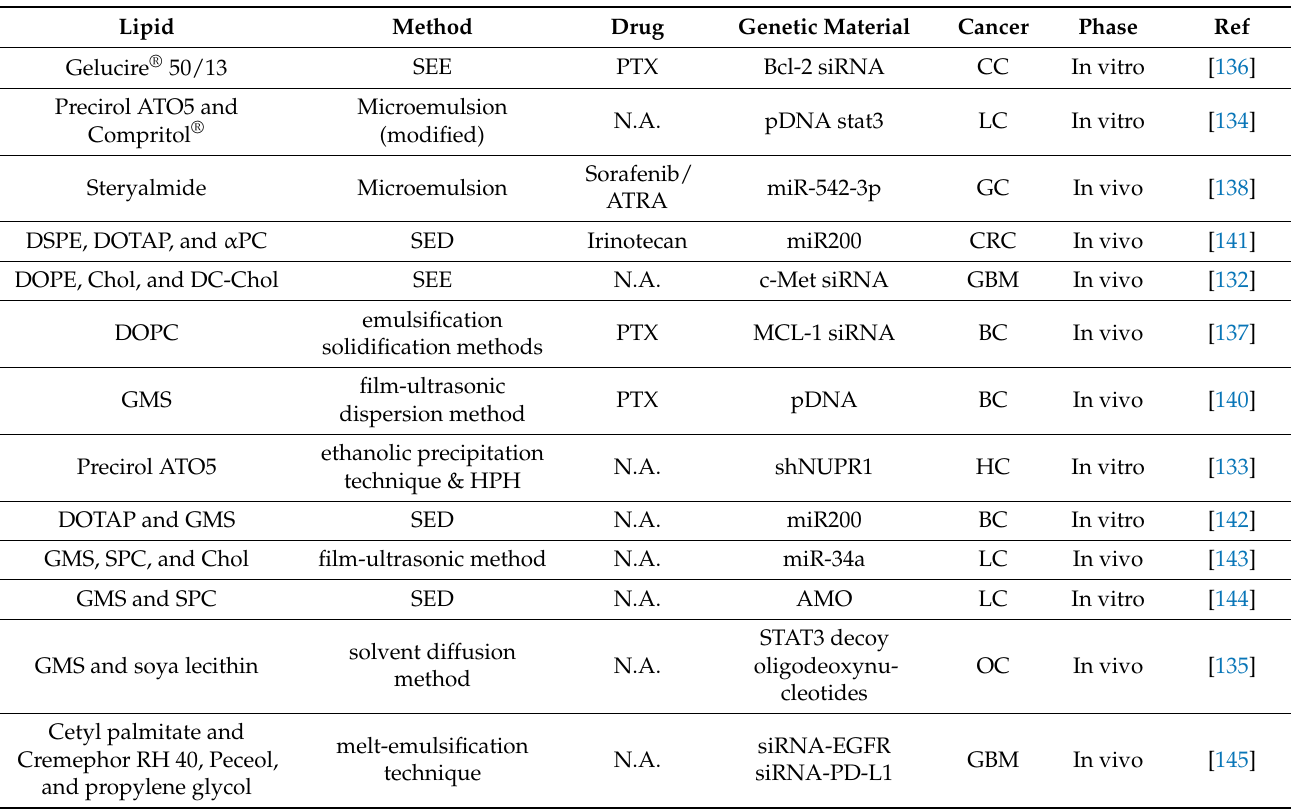
Table 5. SLNs with different genetic material for different cancer types in different stages of develop- ment. N.A.—not